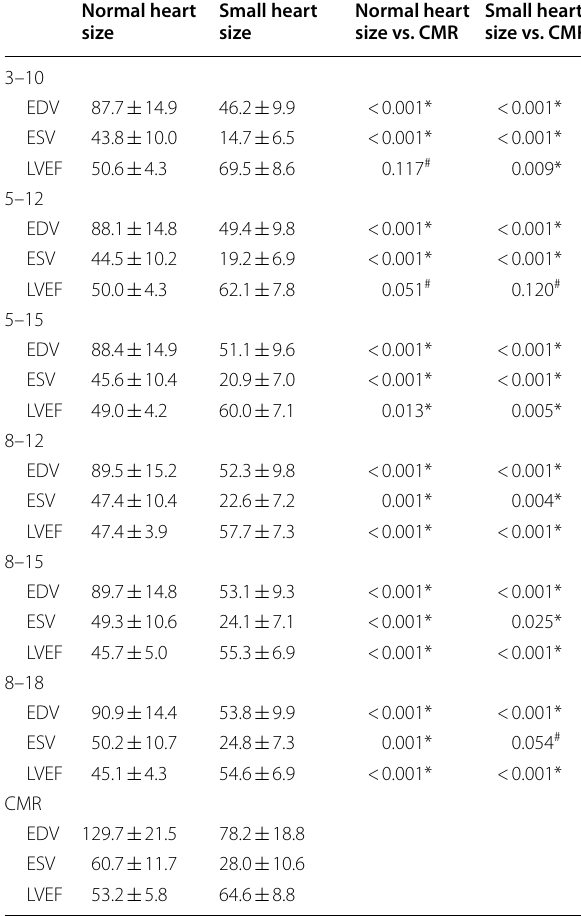
* Represents P < 0.05; # represents P > 0.05, indicating a statistically nonsignificant difference EDV end-diastolic volume, ESV end-systolic volume, LVEF left ventricular ejection fraction, CMR cardiovascular magnetic resonance